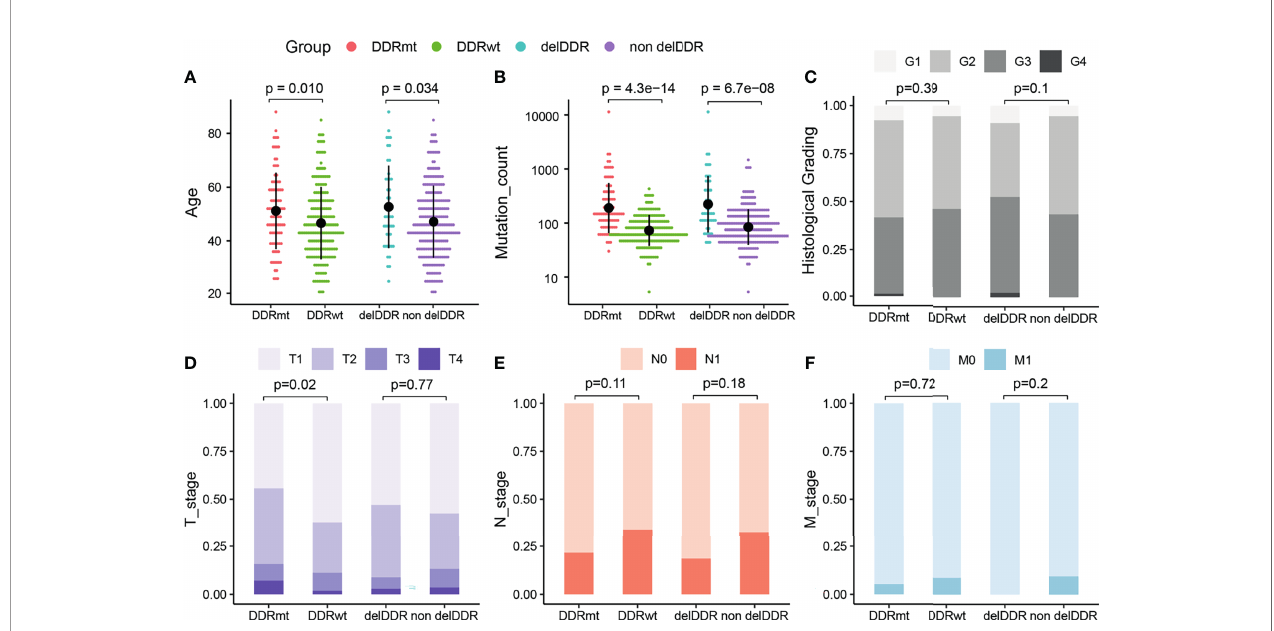
FIGURE 4 | The analyses of clinical features of cervical cancer patients with DDR and DDR alteration from the TCGA cohort. (A) Age at diagnosis of cervical cancer patients with and without any DDR alteration, and patients with deleterious DDR alteration or not. (B) Mutation count of cervical cancer patients with and without any DDR alteration, and patients with deleterious DDR alteration or not. Histological grading (C) , tumor stage (D) , lymph node stage (E) , and metastasis stage (F) of cervical cancer patients with and without any DDR alteration, and patients with deleterious DDR alteration or not. DDRmt, patients with any DDR alteration; DDRwt, patients without any DDR alteration; delDDRmt, patients with deleterious DDR alteration; nondelDDRmt, patients without any deleterious DDR